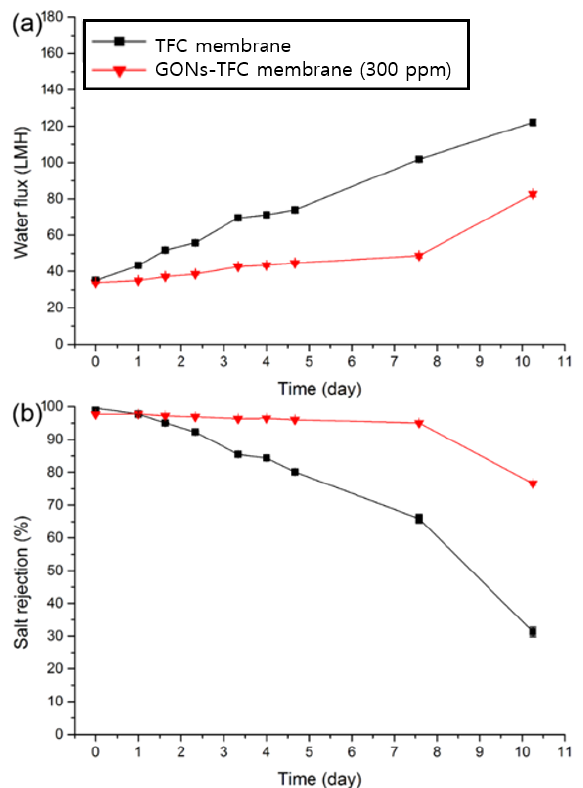
Figure 8. ( a ) Water flux and ( b ) salt rejection of TFC and GONs-TFC (300 ppm) membranes with a 2000-ppm MgSO 4 feed solution. The time in the x -axis represented the time to immerse in sulfuric acid ( n = 3).